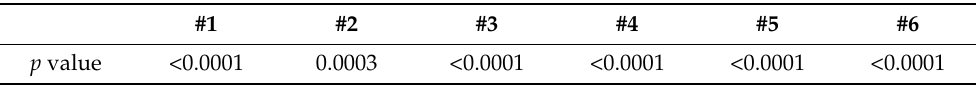
Table 4. IgG antibodies from the sera bind significantly better to the cyclic form of peptides compared to their respective linear form. Signal intensities of serum pools were compared between the two peptide forms. Wilcoxon rank sum test was